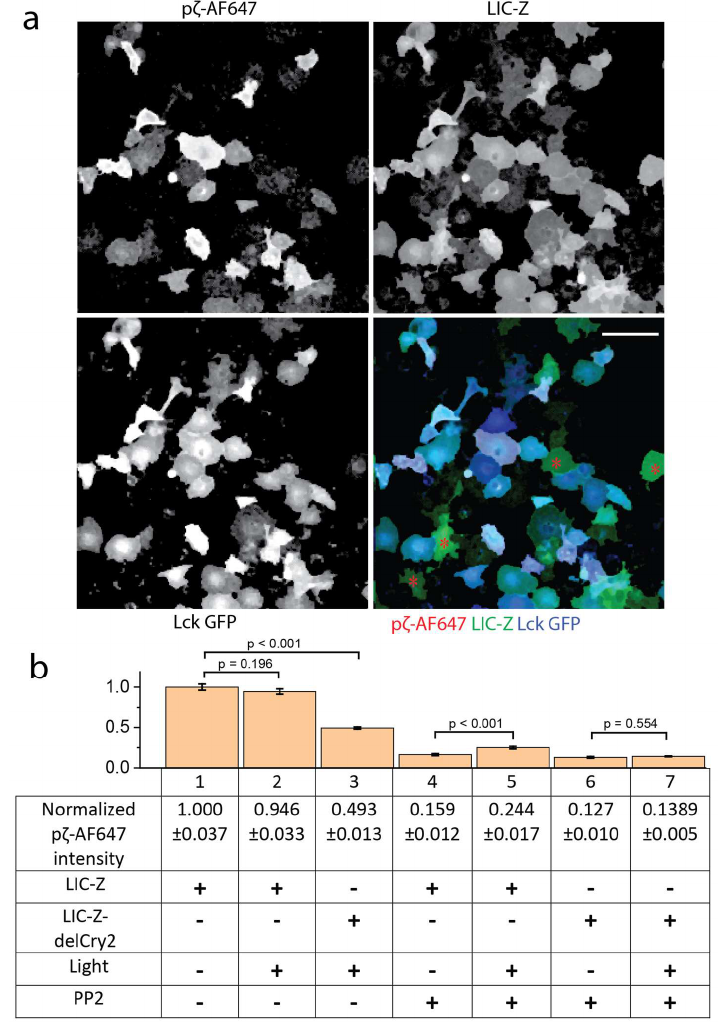
Figure 4. ITAM phosphorylation of LIC-Z and LIC-Z-delCry2 in COS-7 cells. ( a ) Representative intensity images of individual and merged channels of COS-7 cells co-transfected with LIC-Z (green)